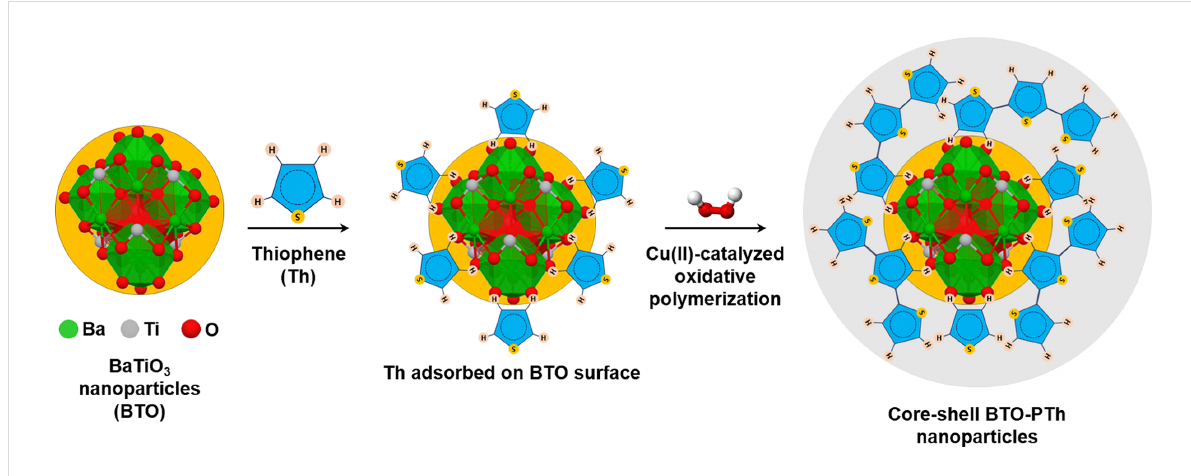
Figure 1: Schematic of the formation of core–shell BaTiO 3 -thiophene (BTO-PTh) nanoparticles. BTO nanoparticles and thiophene (Th) monomer are dispersed in water. Th-monomer molecules adsorb on the surface of BTO nanoparticles through weak intermolecular interactions. The chemical oxi- dative polymerization of Th initiated by H 2 O 2 and catalyzed by Cu 2+ ions yields the core–shell BTO-PTh